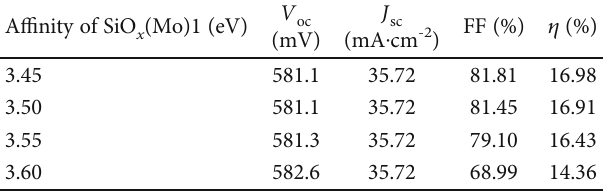
(b) Photovoltaic characteristics of the MoO di ff erent a ffi nities of the SiO (Mo)1 layer x (Mo)1 (eV) A ffi nity of SiO x